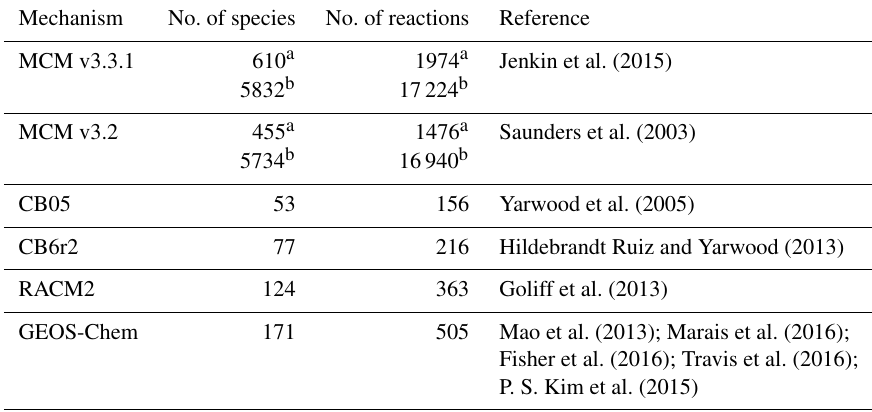
Table 1. Chemical mechanisms in F0AM